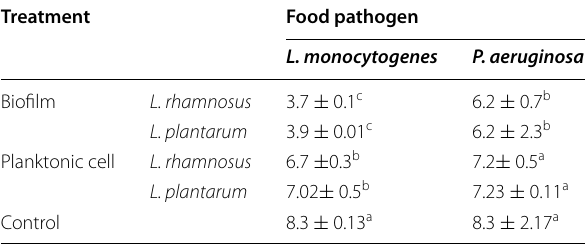
Table 1 Antagonistic activity associated with Lactobacillus strains on foodborne pathogen